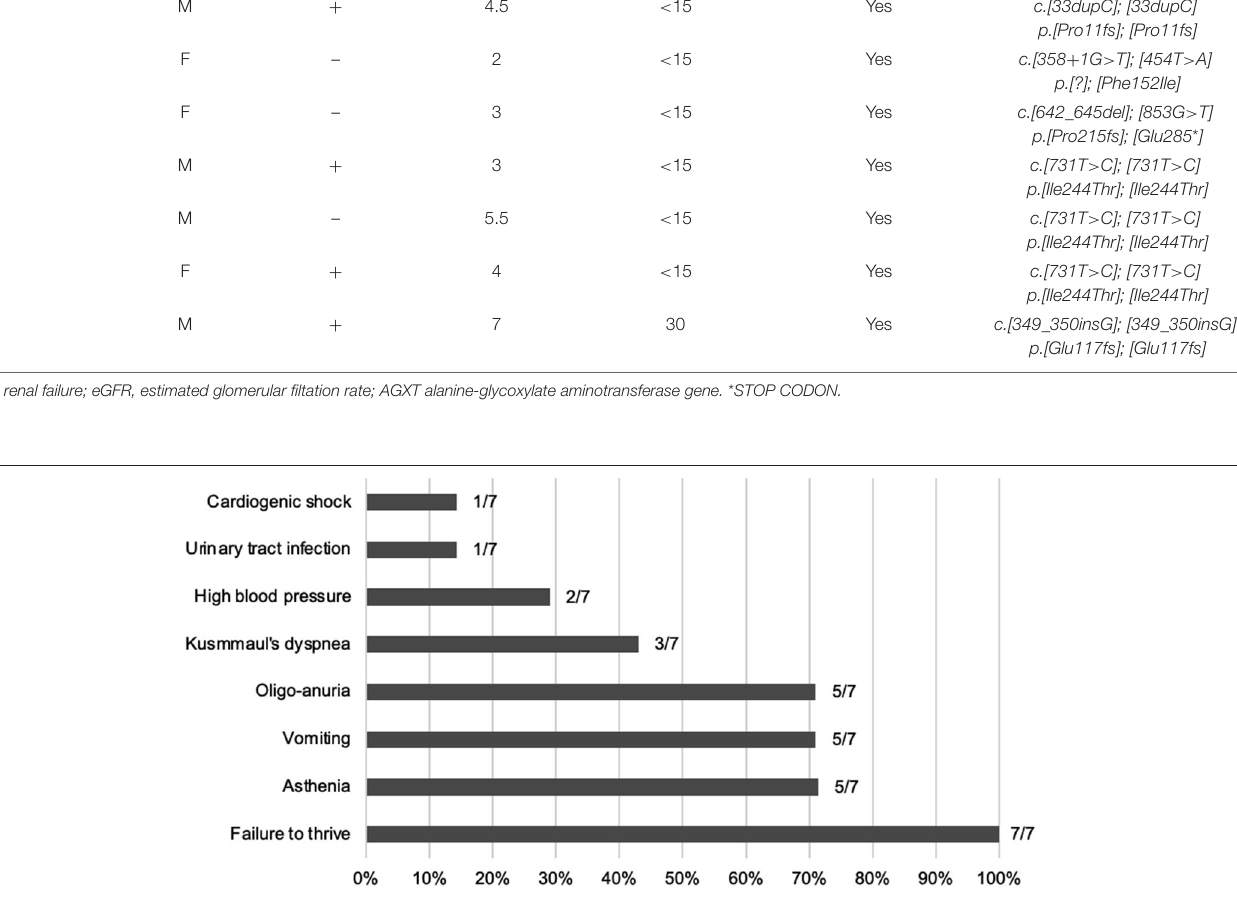
FIGURE 1 | Frequency of the clinical features at diagnosis.